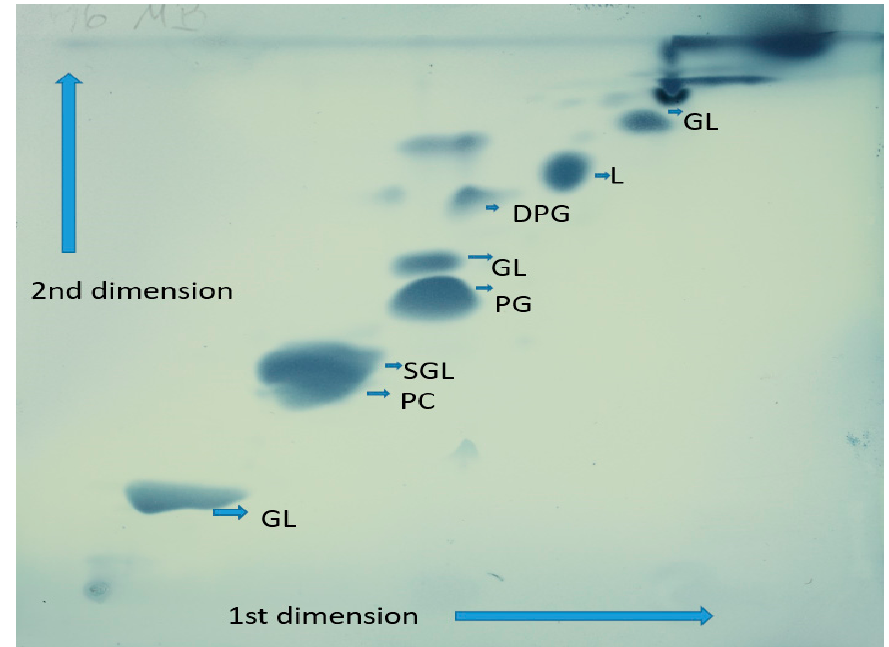
Figure 3. Polar lipids observed in strain NZ-96 T are DPG: diphosphatidylglycerol; GL1-3: unknown glycolipid; PGL: unknown phosphoglycolipid; L: Unknown polar lipid; PG: Phosphatidylglycerol; SGL: Sphingoglycolipid; PC: Phosphatidylcholine. Table 1. Fatty acids profiles of strain NZ-96 T and the phylogenetically closest relatives. Strains 1: NZ-96 T ; 2: Qipengyuania citreus RE35F/1 T ; 3: Erythrobacter aureus YH-07 T ; and 4: Qipengyuania pelagi